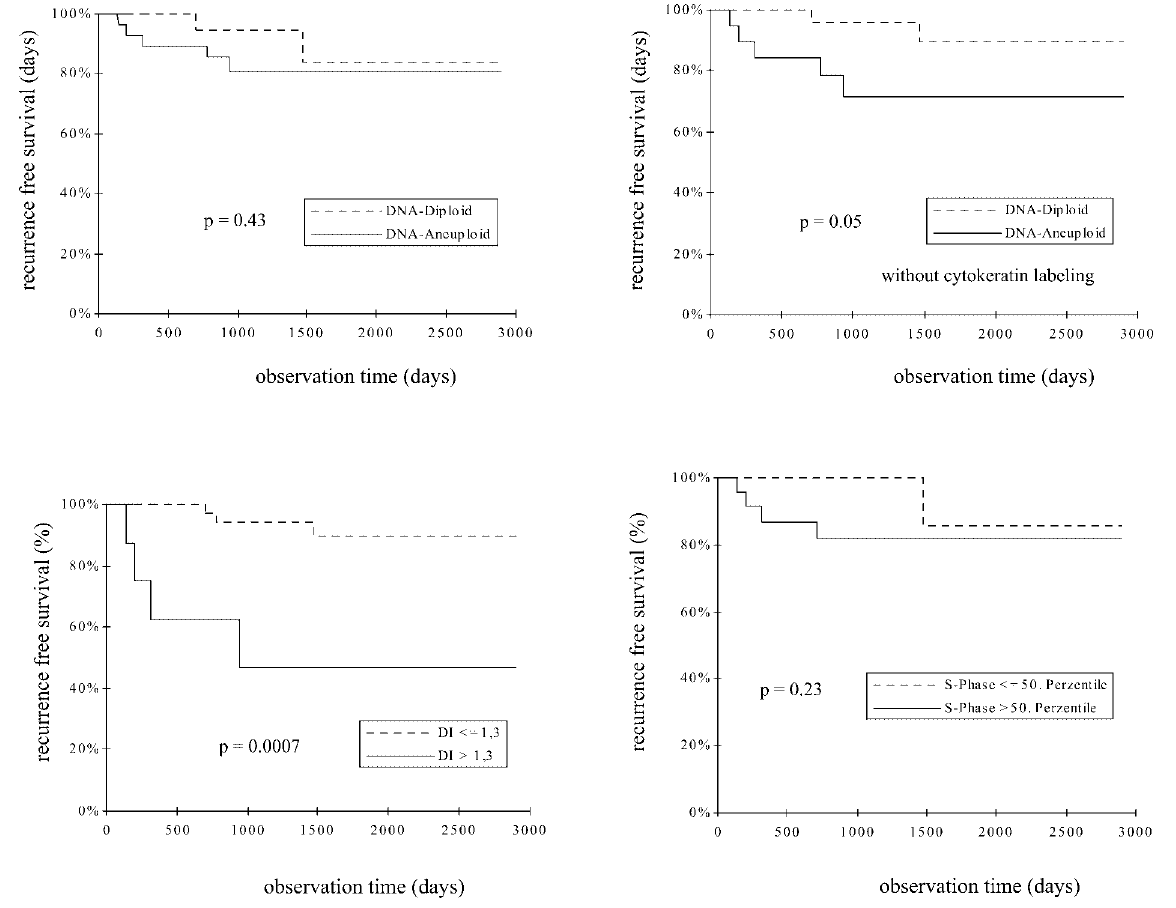
Fig. 2. Endometrial cancer ( n = 52). Kaplan–Meier curves for RFS in dependence on DNA-ploidy (with and without cytokeratin labelling), DNA-index and S-phase fraction were performed. The significance level ( p ) was determined by univariate analysis with the log rank